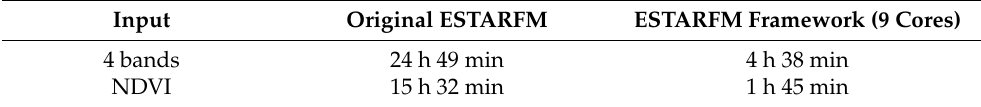
Table 1. Overview of processing times with the original ESTARFM and the ESTARFM framework using nine CPU cores. The processing was tested with four reflectance bands and one band of